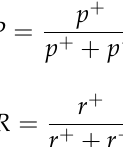
Figure 9. The F1-Measure for different distance and time thresholds